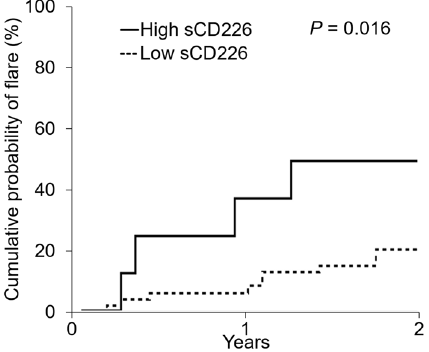
Figure 3. Kaplan–Meier analysis for cumulative probability of flares for patients with different levels of sCD226. Curves were compared using log-rank tests. sCD226 soluble CD226.